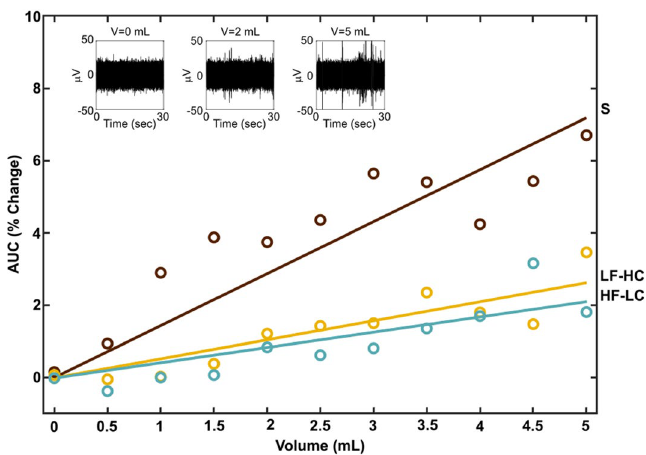
Figure 3. The change observed in the mean area under the curve (AUC) within vagal nerve recordings as a function of stomach volume across trials and MEA channels. Diet types are standard (S), low fat high carbohydrate (LF-HC), and high fat low carbohydrate (HF-LC). Circles indicate means across animals, time samples, and MEA channels for each injected volume binned in 0.5 mL increments. Linear regression R 2 values: 0.70, 0.80, and 0.73 for the standard, LF-HC, and HF-LC diets, respectively. The insets show 30 s of raw ENG at three different volumes from one MEA channel of one trial in an animal fed the standard diet.